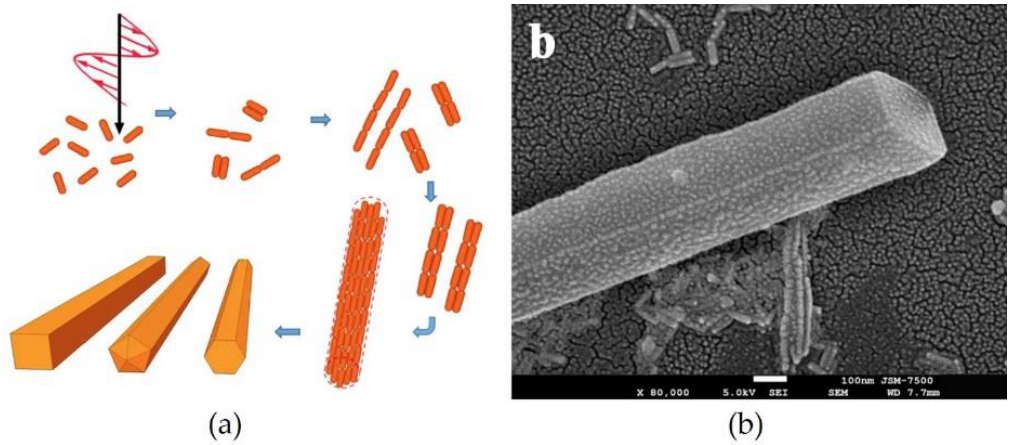
Figure 6. ( a ) Scheme of the formation of the Au nanowires; ( b ) and SEM image of the nanowire obtained by light application. Reproduced with permission from Reference [63] (Copyright 2017 Springer Nature).